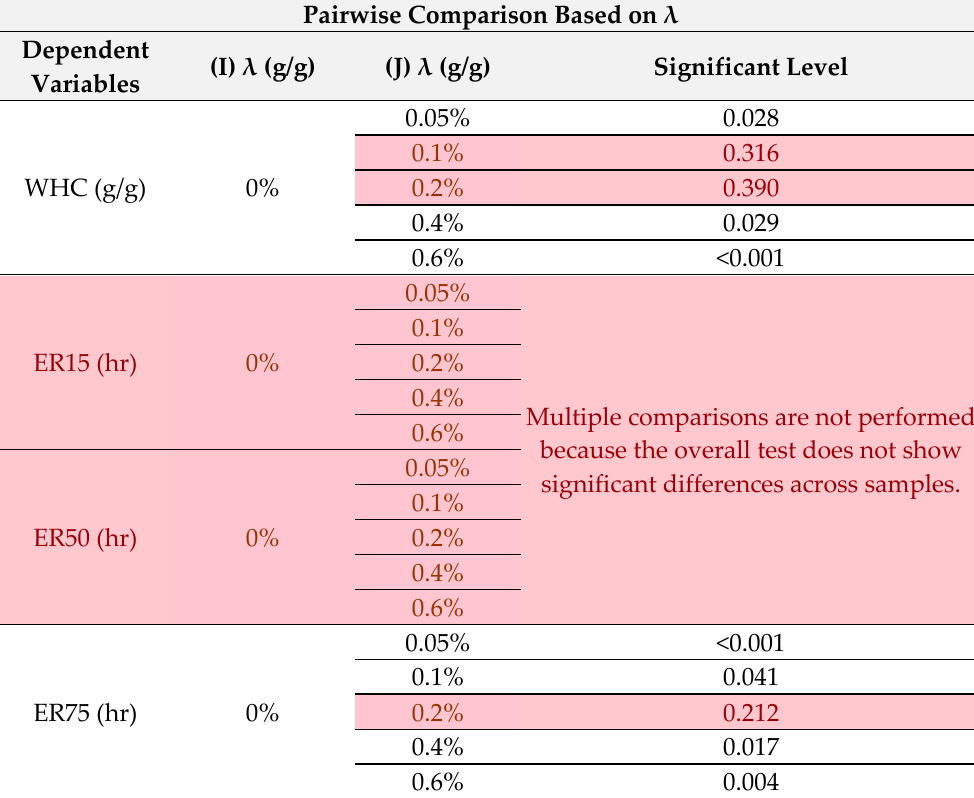
Table 3. Results of the Kruskal–Wallis (fiber) analyses. Considering α = 0.05, we find, excepting the highlighted ones, there are statistically significant differences for each subject factor.